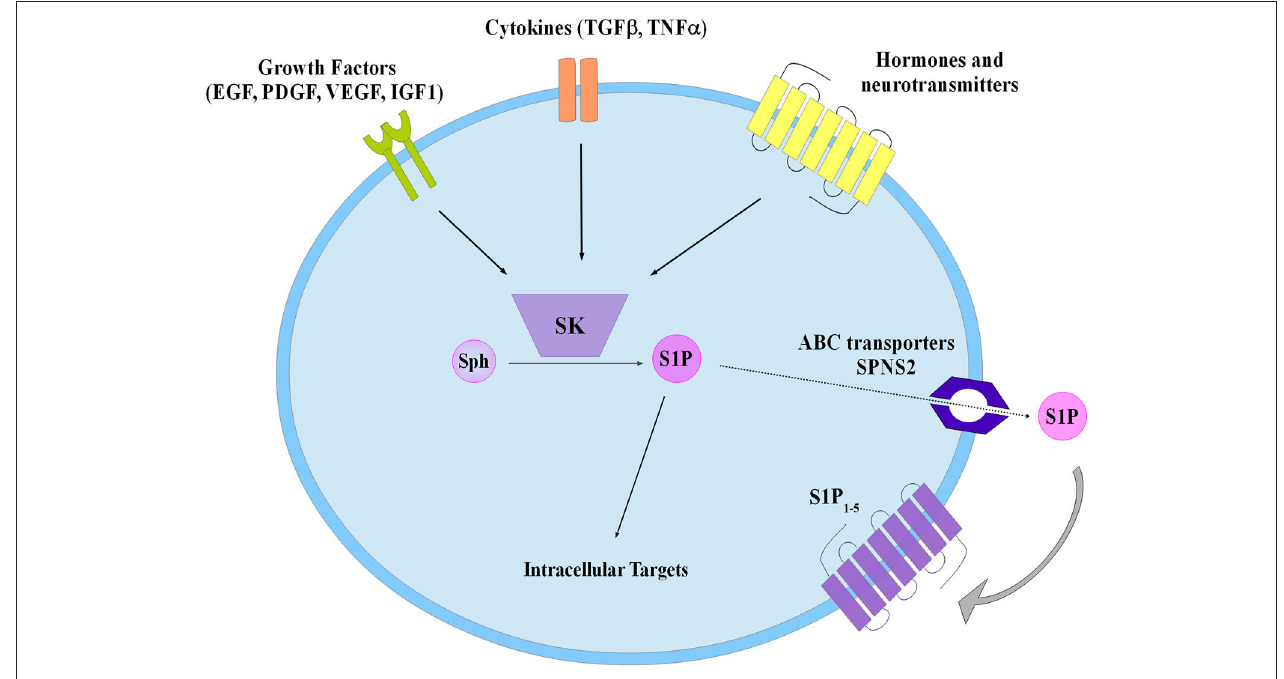
released to bind specific S1P receptors (S1P 1–5 ). Transporters have been involved in S1P export such as the ATP binding cassette (ABC), and the specific spinster 2